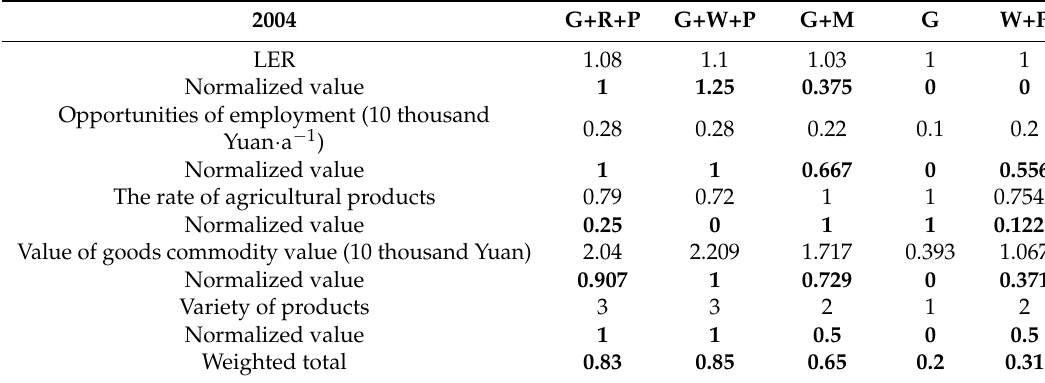
Table A3. Social indicator values from three mixed Ginkgo systems, pure Ginkgo (G), and a cropping system (W+P), in 2004.